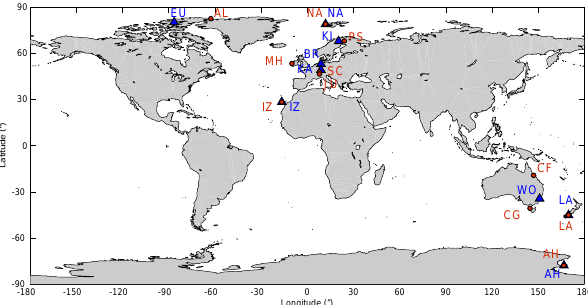
Fig. 2. NDACC FTIR stations in blue solid triangles and GAW in-situ stations in orange solid circles. Figure 2. NDACC FTIR stations in blue solid triangles and GAW See Tables 1 and 4 for the full station names. in situ stations in orange solid circles. See Tables 1 and 4 for the full station